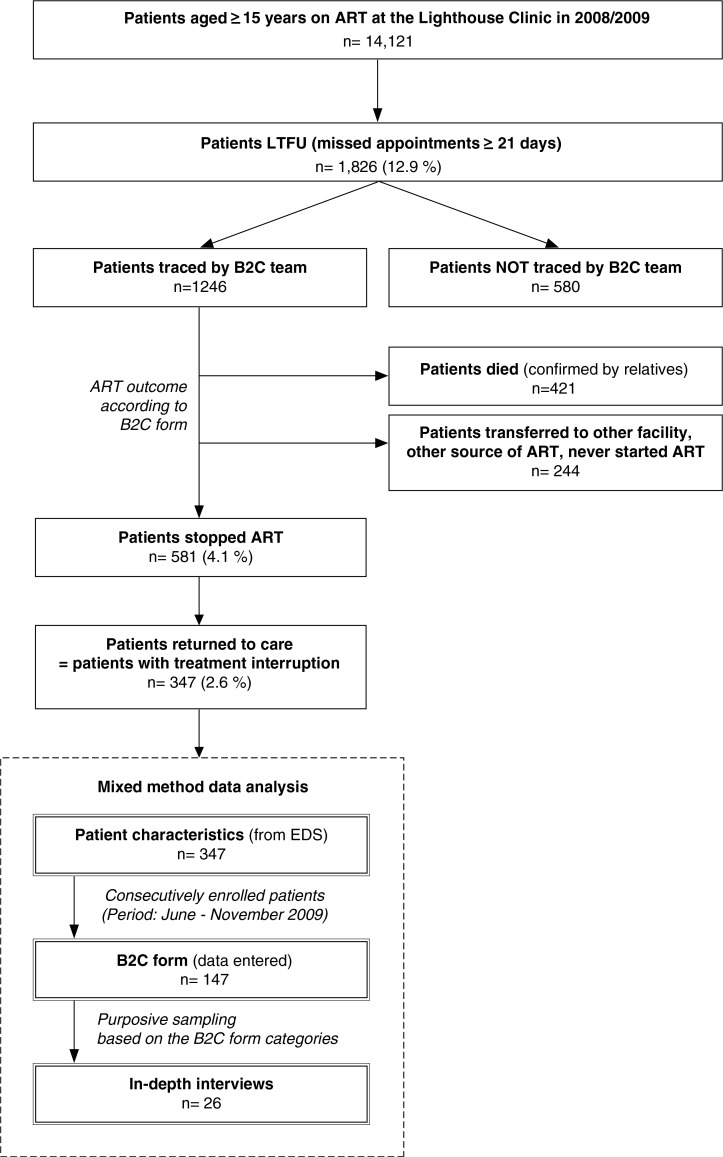
Study population. Eligibility criteria were ≥15 years, documented treatment interruption of ≥21 days (between January 2008 and November 2009), resumption of ART. In total, patient characteristics of 347 patients were analysed, 147 B2C forms were entered into an MSAccess database and 26 in-depth interviews were conducted for descriptive analysis and to gain a further understanding of reasons for treatment interruption.ART: Antiretroviral therapy; B2C: Back-to-Care; EDS: Electronic data system; LTFU: Lost-to-Follow up